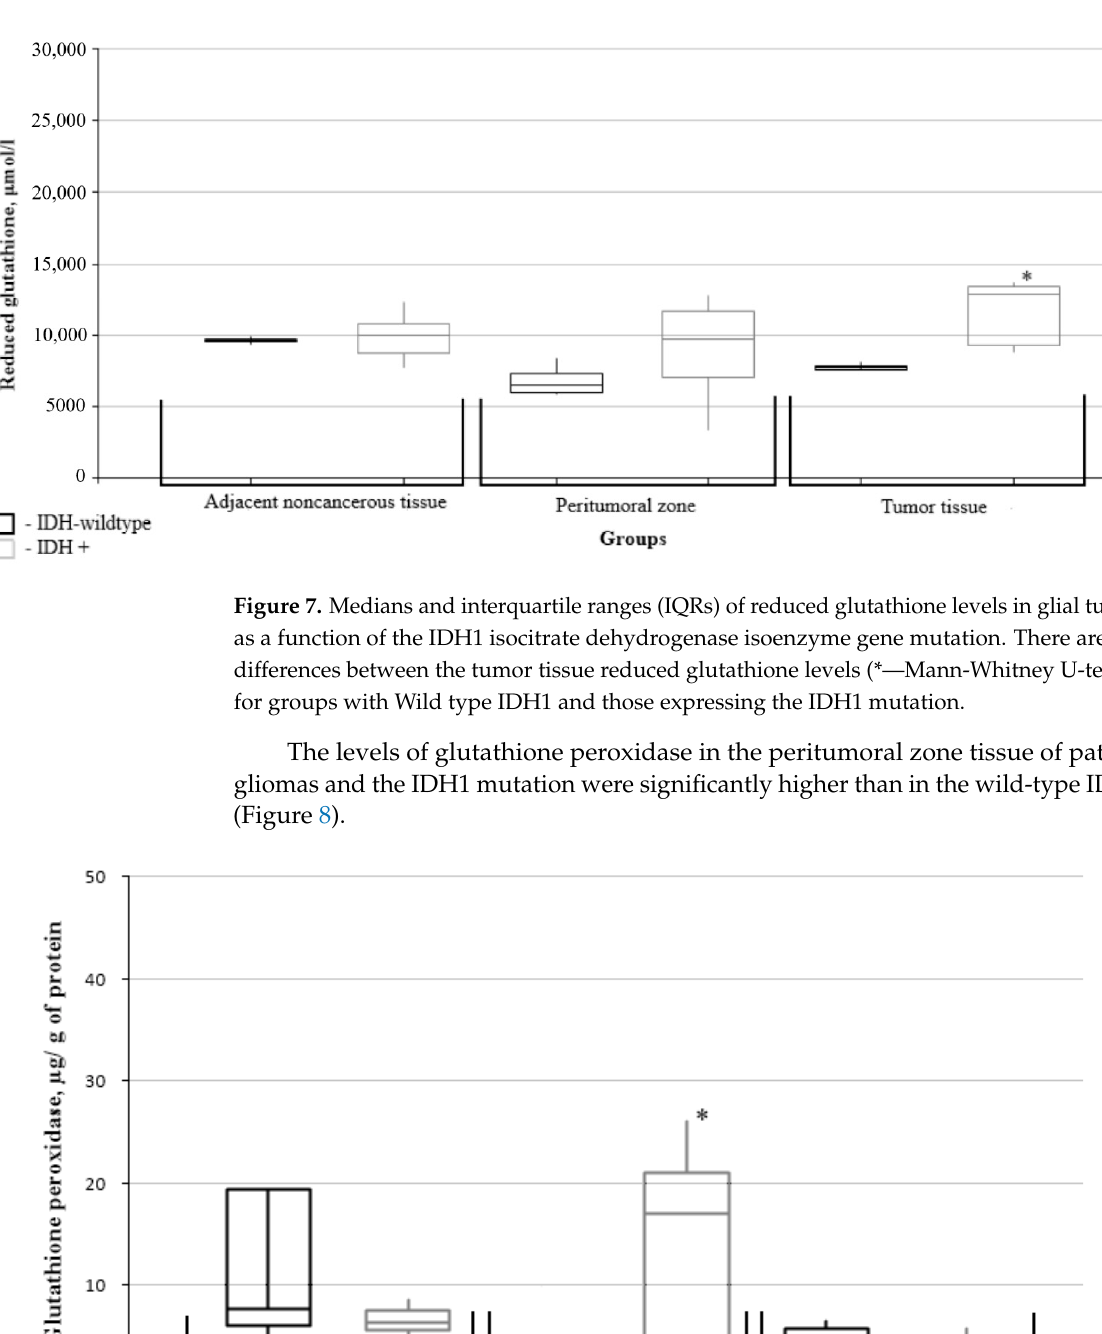
Figure 6. Medians and interquartile ranges (IQRs) of glutathione S-transferase levels in gliomas as a function of the Ki-67 mitotic index value. There are significant differences between the glutathione transferase levels in the peritumoral zone tissues (* ̵ Mann-Whitney U-test p = 0.007) and the tumors (* ̵ Mann-Whitney U-test p = 0.010) for the low and high mitotic index Ki-67 groups. The content of reduced glutathione in the tumor tissues of patients with gliomas and the IDH1 mutation was significantly higher than in the wild-type IDH1 group (Figure 7).